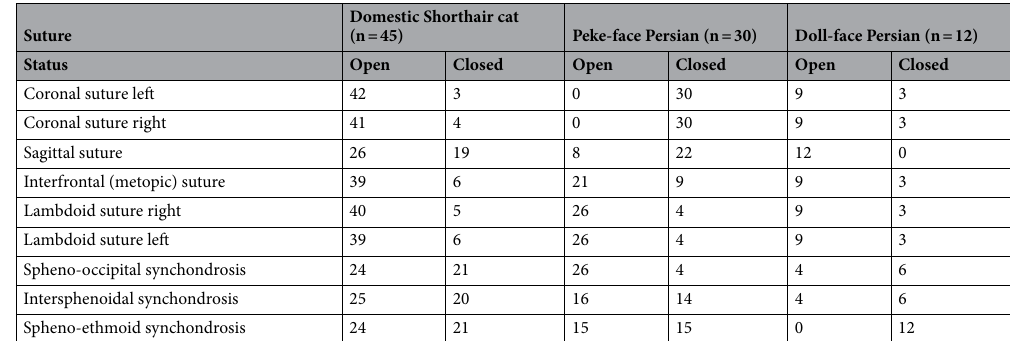
Table 1. Overview of the open or closed status in the examined MCTs in the different groups of cats.